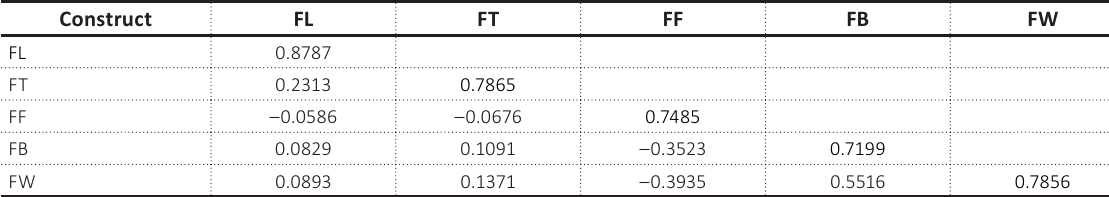
Table 5. Latent variable correlations and square root of AVE values (diagonal)